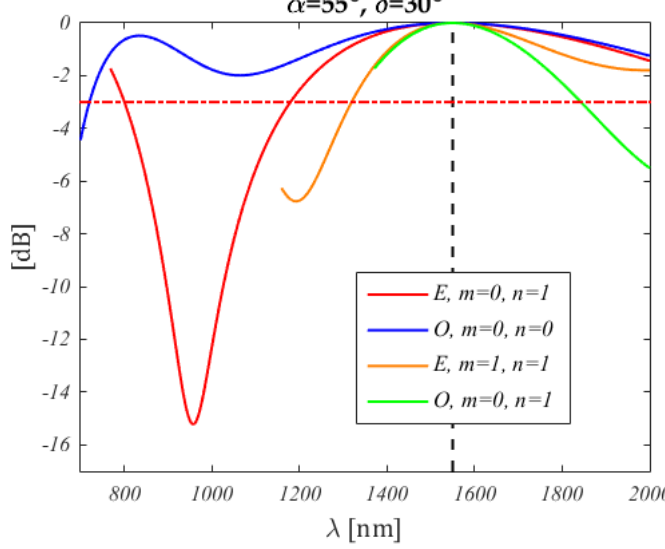
Figure 18. Spectra corresponding to the lines in Figure 17 (the colours correspond), for f 0 = 1934THz (1550nm, indicated by the black dashed vertical line). The wavelength ranges have been chosen to represent only the portion of the ( φ 1 , φ 2 ) plane shown in Figure 17. Note that the upper wavelength limit is the same, whereas the lower one increases with the solution distance from the origin. In general, the spectra are neither symmetric nor periodic. The legend lists the solution class (even or odd) and their order. The fundamental even solution is not reported, as it lies in the lower ( φ 1 , φ 2 ) half